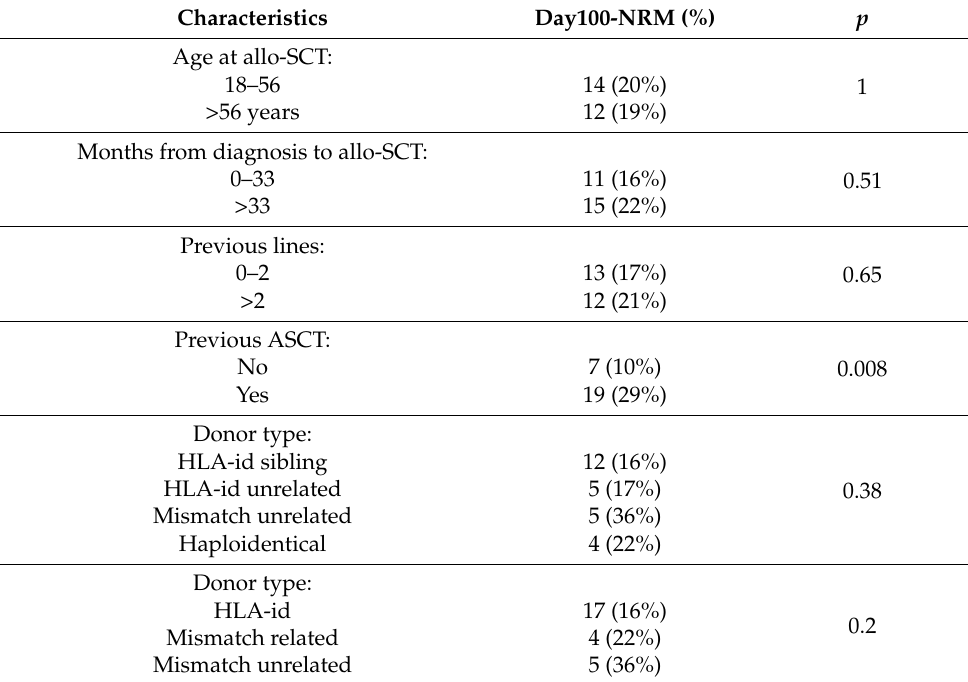
Figure 1. Main outcome data of the patients including event-free survival ( A ), overall survival ( B ), CI of relapse ( C )and CI of NRM ( D ). Table 2. Analysis of clinical factors influencing non-relapse